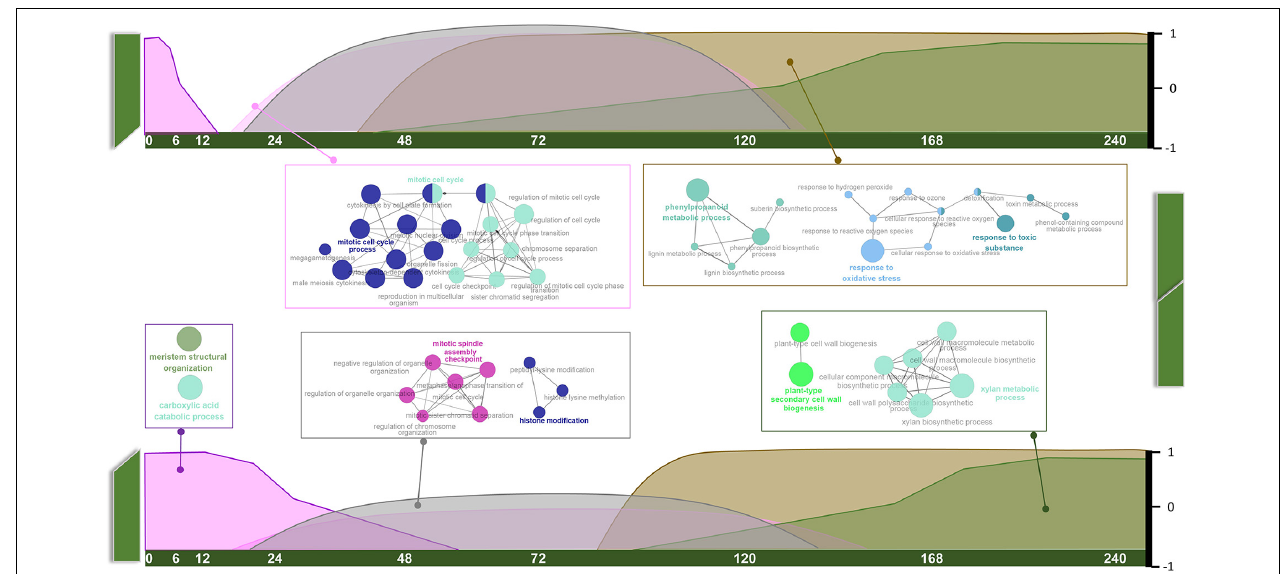
FIGURE 3 | Schematic diagram of temporal variation characteristics and GO annotations of common